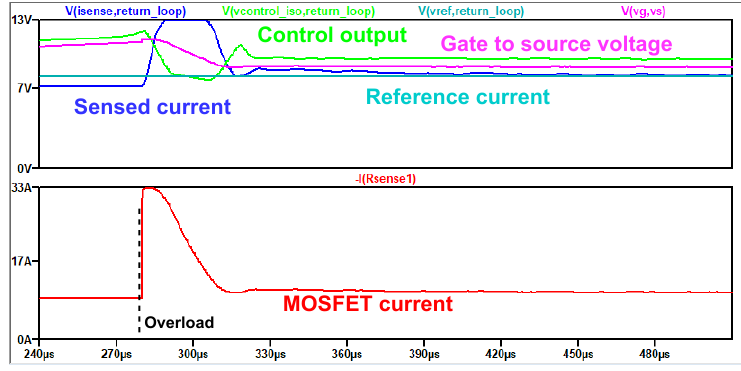
Figure 12. LTSPICE simulation results of the